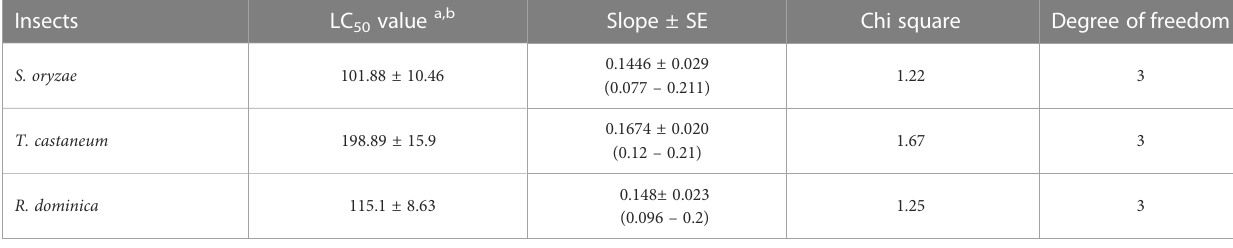
a LC 50 = μg/L air. b Values in parenthesis represent con fi dence limits by probit analysis (Finney, 1971), n=4.